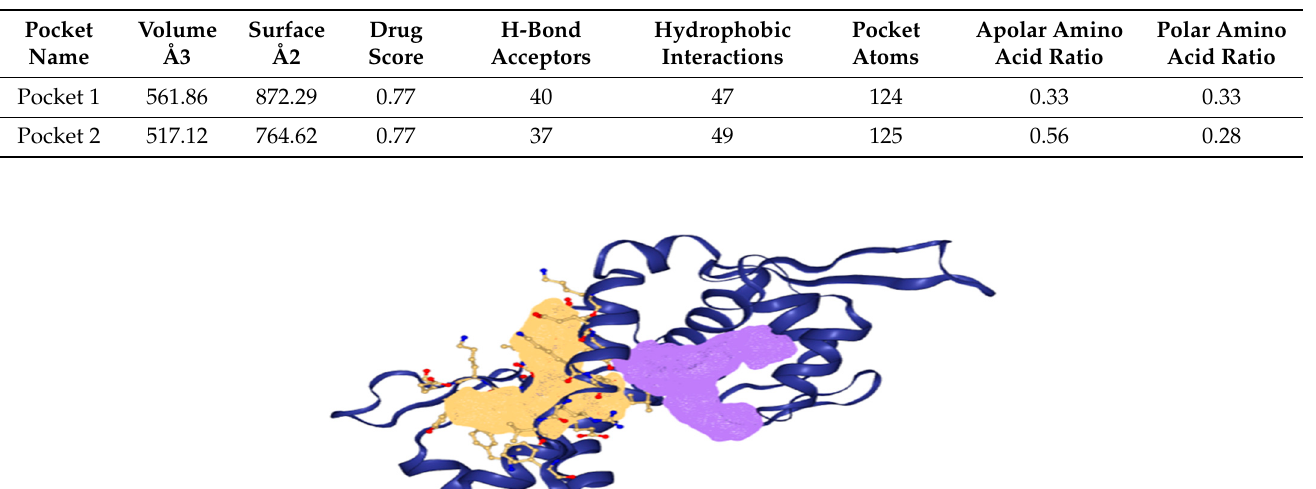
Figure 2 . Binding pockets of MAGE-A (the pocket represented in yellow is pocket 1, and the pocket represented in purple is pocket 2) .